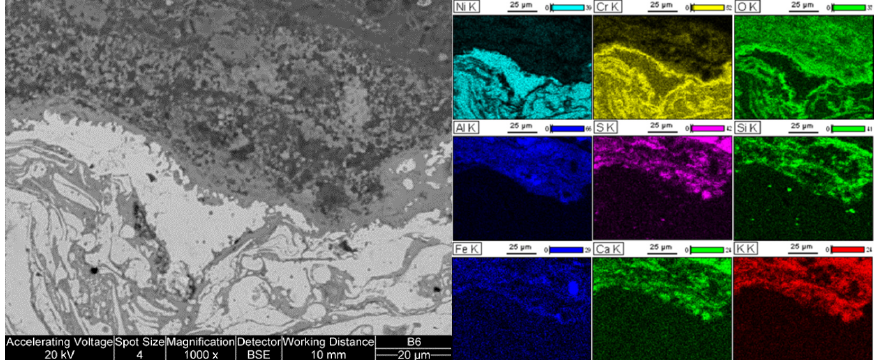
Figure 11. SEM (BSE) image of the outer surface of the arc sprayed NiCrTi coating and EDX map analysis from the leeward side.